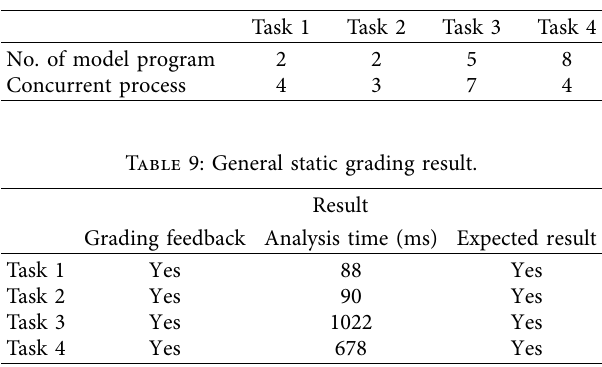
Table 8: General testing condition.